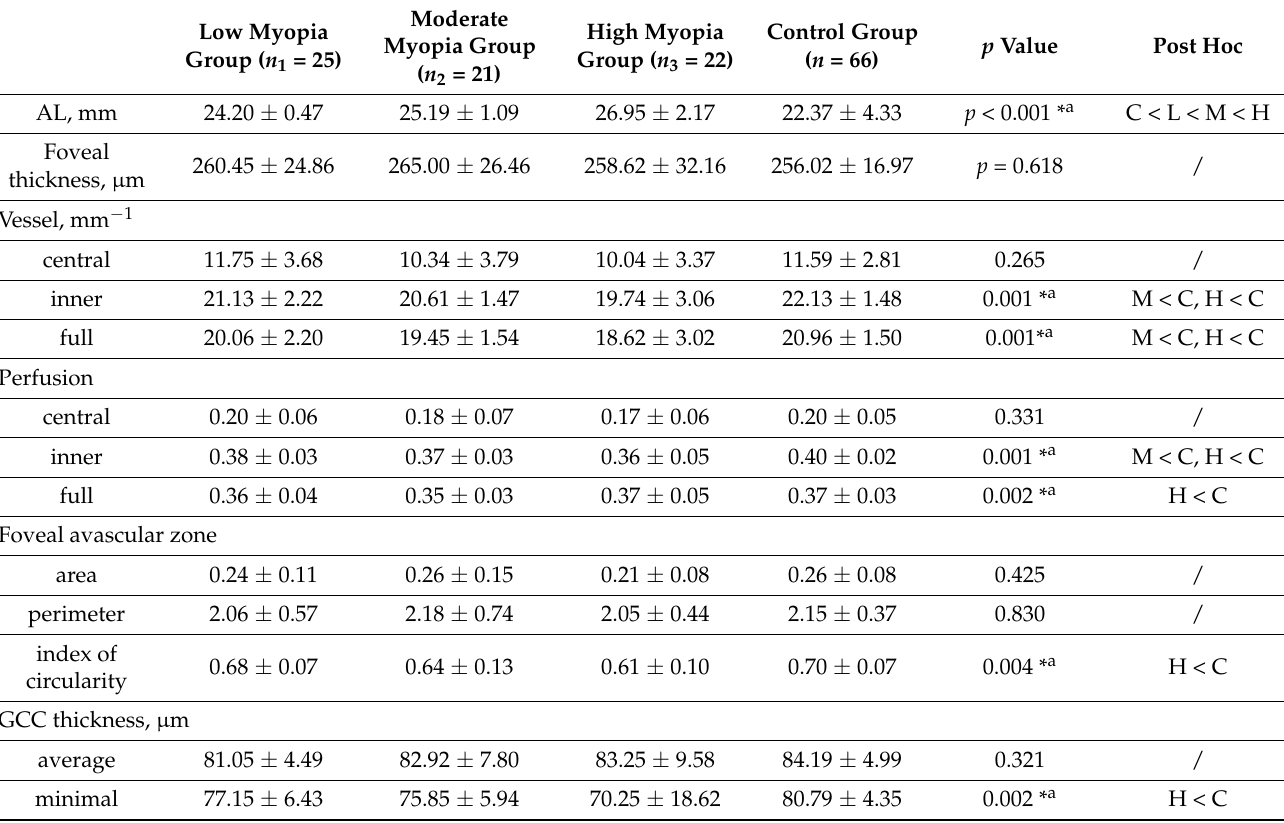
Table 2. Results of statistical analysis for measured OCTA